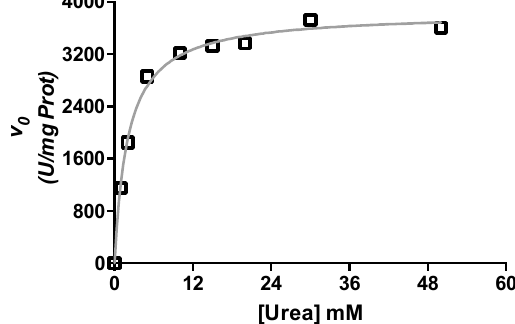
Figure 1. Saturation kinetics of Citrullus vulgaris urease (CVU) by urea. The observed initial velocities of reaction are plotted against diferent concentrations of urea. U is defined as the amount of enzyme that produces one micromol of NH 3+ min − 1 · mL − 1 . The grey line shows the best curve fitting to Equation (1). Non-linear curve fitting and plot were prepared using Graph Pad Prism 5 ® (GraphPad Software, Inc., La Jolla, CA, USA) and one of three typical experimental results is used here as indicated in the Methods section.